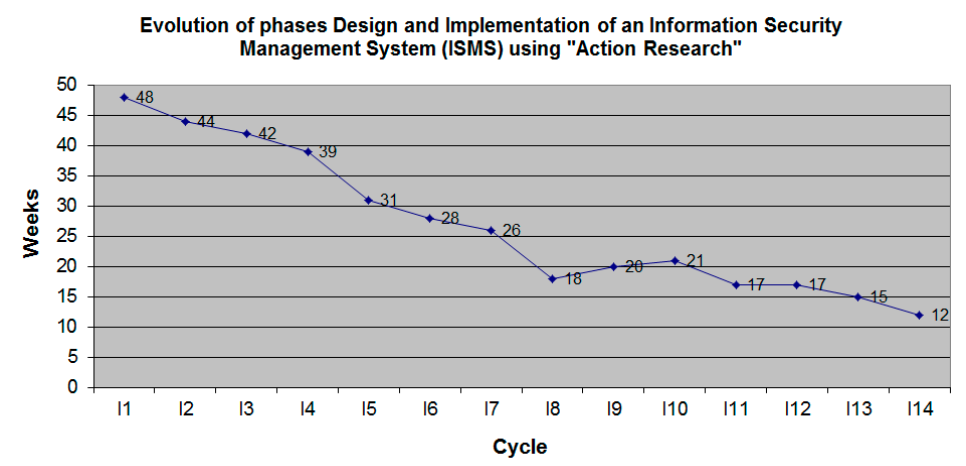
Figure 4. Evolution of the design and installation phases of an ISMS using AR.